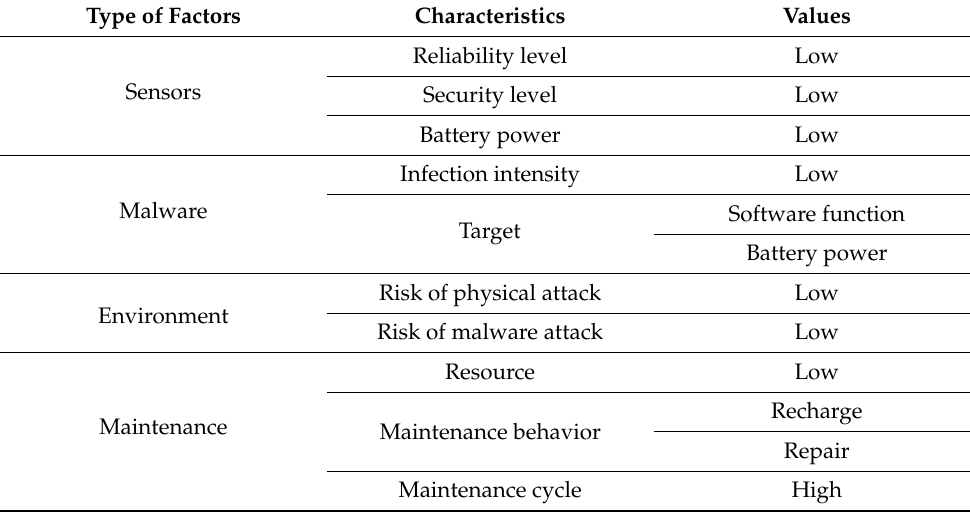
Table A6. Scenario 3 with characteristics and values.